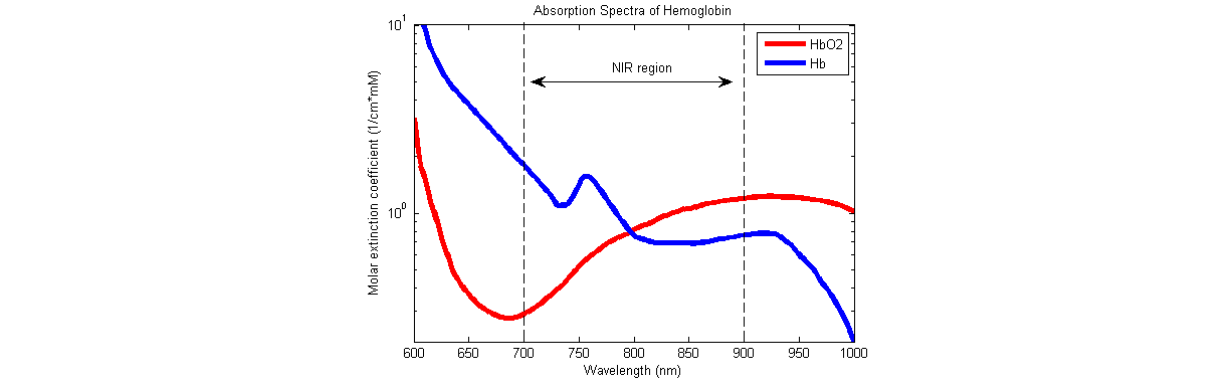
Figure 1. Absorption spectra of oxygenated and deoxygenated hemoglobin. Licensed from Adrian Curtin/CC BY-SA. Hb: deoxygenated hemoglobin; HbO 2 : oxygenated